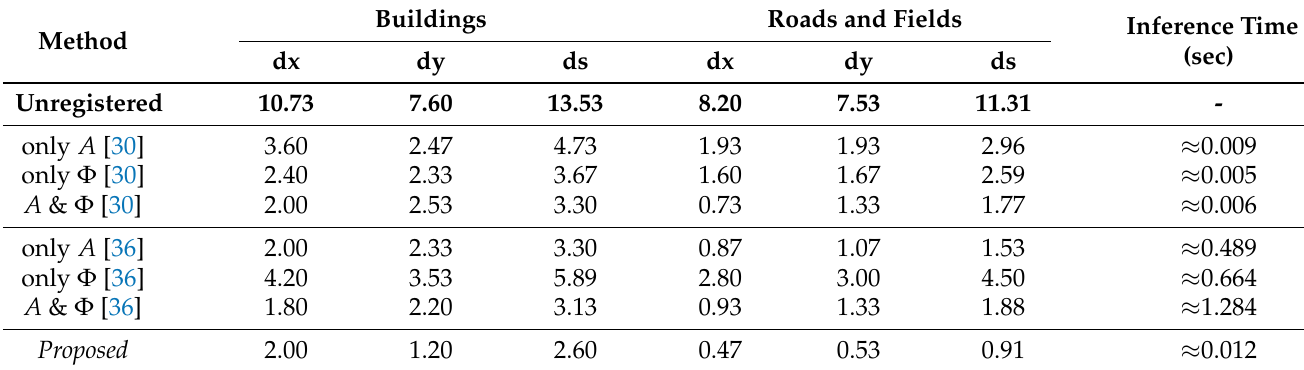
Table 2. Errors measured as average euclidean distances between 15 landmark locations on the testing images of the Attica VHR dataset. dx and dy represent the distances along the x and y axis, respectively. ds indicates the average error along all axes per pixel, while the last column indicates the time needed by the methods to register a pair of 256 × 256 images. Errors on building landmark locations ( left ) and errors related to points on roads and fields ( right ) are presented.